Question: State the chart type depicted above.
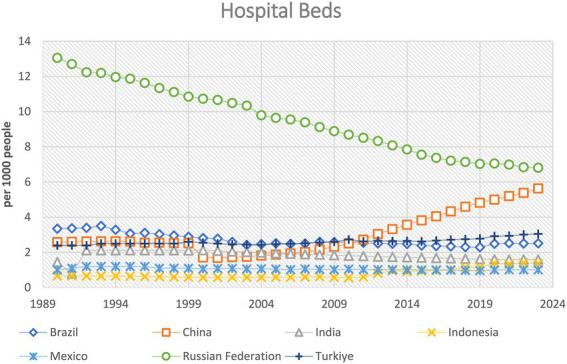
Answer: line